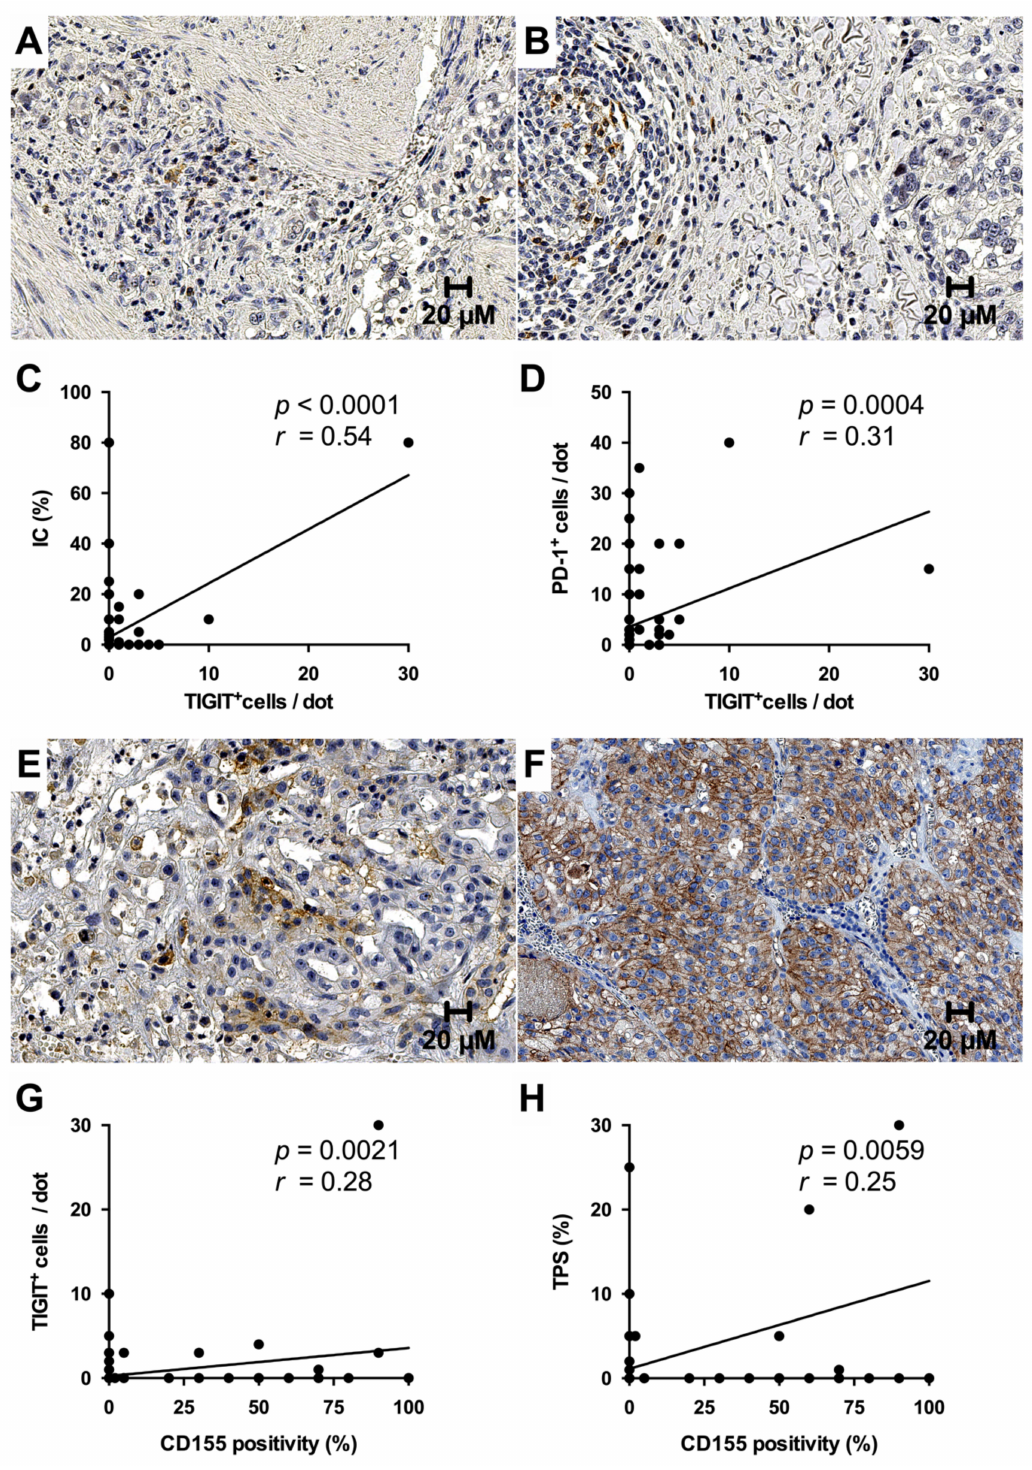
Figure 6. Expression of TIGIT and CD155 in gallbladder cancer. TIGIT was exclusively expressed by tumor-associated immune cells and mostly restricted to single lymphocytes ( A ). Only a few cases showed aggregated TIGIT + immune cell clusters ( B ). TIGIT positivity in immune cells closely correlated with PD-L1 and PD-1 expression ( C , D ). CD155 immunohistochemistry showed a mostly strong membranous signal, that ranged from focal ( E ) to ubiquitous ( F ). CD155 positivity significantly correlated with the number of TIGIT + immune cells and PD-L1 expression in tumor cells ( G , H ). Original magnification in ( A , B , E , F ): 400 ×